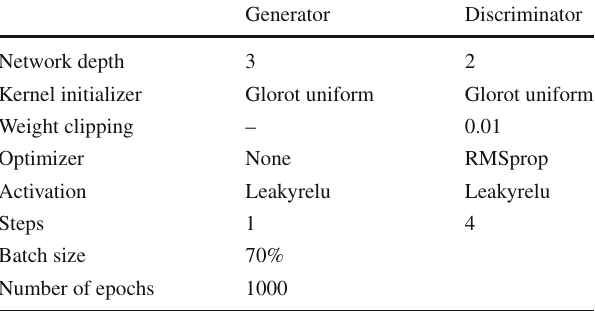
Fig. 3 Flowchart describing the combined GANs and compres- sion framework. The ganpdfs code is interfaced with the pyCompressor code from which input arguments related to the enhancement and compression are passed Table 1 Parameters on which the hyper-parameter scan was performed are shown in the first column. The resulting best values are shown for both the generator and discriminator in the second and third column